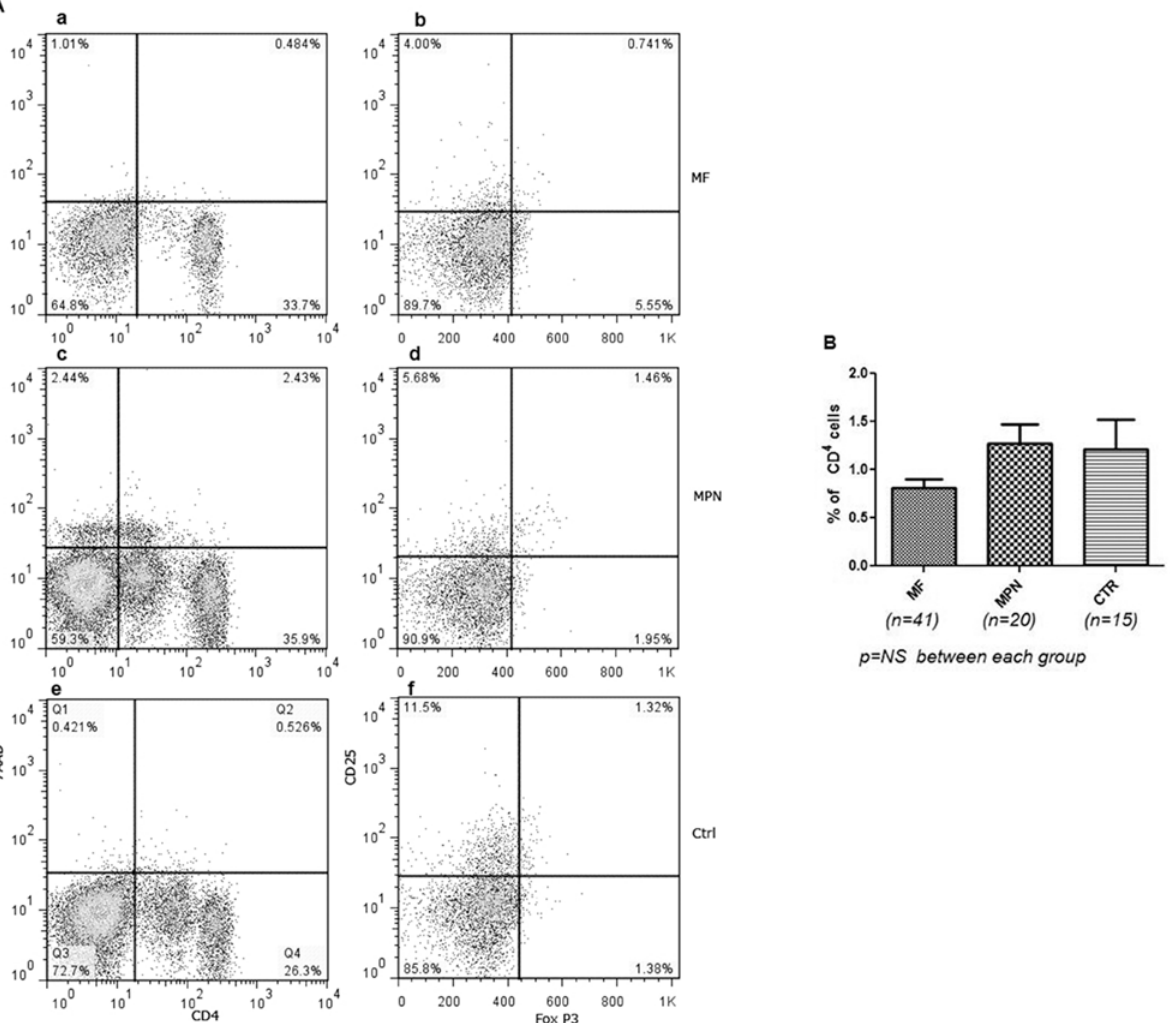
Fig 1. Treg cells in patients with MF and other MPNs. 41 patients with MF including PMF (n = 33), post-ET MF (n = 5), and post-PV MF (n = 3), and other MPN patients including PV (n = 15) and ET (n = 5) were studied. 15 normal volunteers were used as controls. Mononuclear cells from peripheral blood obtained from patients were analyzed by flow cytometry with the T regulatory Detection Kit. (A) Representatives of flow cytometric analysis of Treg cells in peripheral MNC. The viable CD4+ cells (lower-right quadrant) in inserts a, c, and e were further analyzed for CD25+ FoxP3+ cells (upper-right quadrant in inserts b, d, and f). The number of Treg cells was calculated as the percentage of CD4 + CD25 + FoxP3 + T cells (Treg) from the number of gated CD4 + cells. (B) Comparison of Treg cells in MF patients with other MPD patients and controls. No significant difference was found between the groups. MF = myelofibrosis, MPN = myeloproliferative neoplasm, CTR =